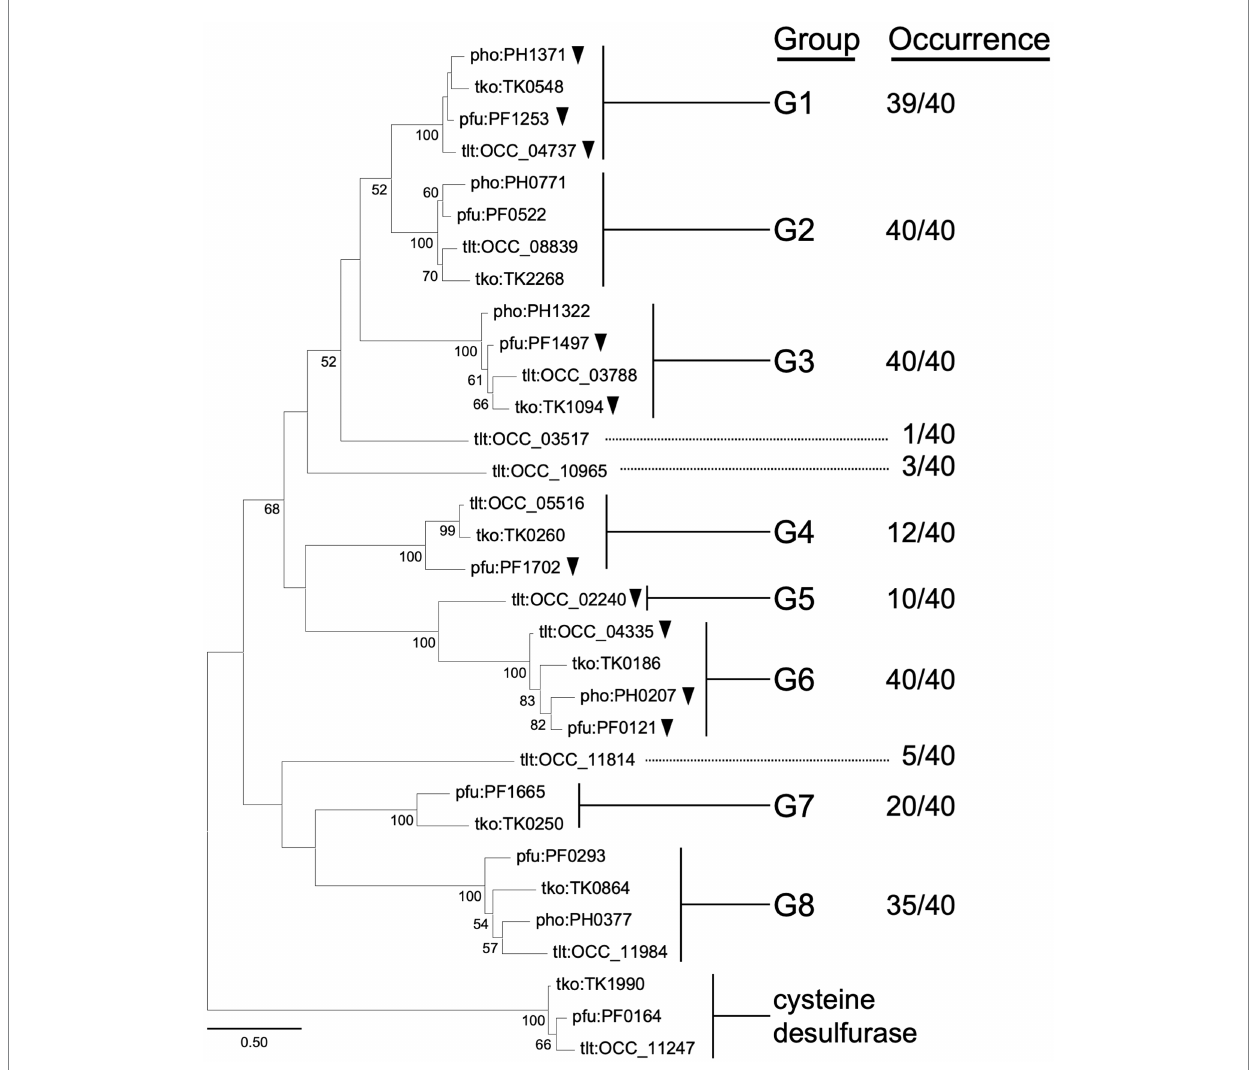
FIGURE 1 Phylogenetic analysis of Class I aminotransferases from selected species of Thermococcales. Amino acid sequences were collected from T. kodakarensis , T. litoralis , P. furiosus , and P. horikoshii . Homologs of cysteine desulfurase (TK1990) were added into the dataset as an outgroup. The sequences were aligned using MUSCLE algorithm (Edgar, 2004). The phylogenetic analysis was performed using the Maximum Likelihood method and JTT matrix-based model (Jones et al., 1992). The tree with the highest log likelihood ( − 9712.68) is shown. The percentage of trees in which the associated taxa clustered together is shown next to the branches. Bootstrap values above 50 are shown. Initial tree(s) for the heuristic search were obtained automatically by applying Neighbor-Join and BioNJ algorithms to a matrix of pairwise distances estimated using the JTT model, then selecting the topology with superior log likelihood value. The tree is drawn to scale, with branch lengths measured in the number of substitutions per site. This analysis involved 32 amino acid sequences. All positions containing gaps and missing data were eliminated (complete deletion option). There were a total of 242 positions in the final dataset. Evolutionary analyses were conducted in MEGA11 (Tamura et al., 2021). Homologs that have been characterized genetically or biochemically are indicated with black arrowheads. Information on the groups or occurrence is indicated in the